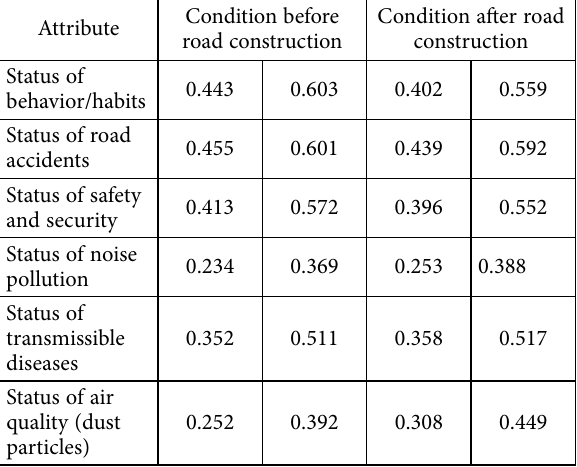
Figure 6. The concept of ( Table 9. Left and right interval ratings of the attribute